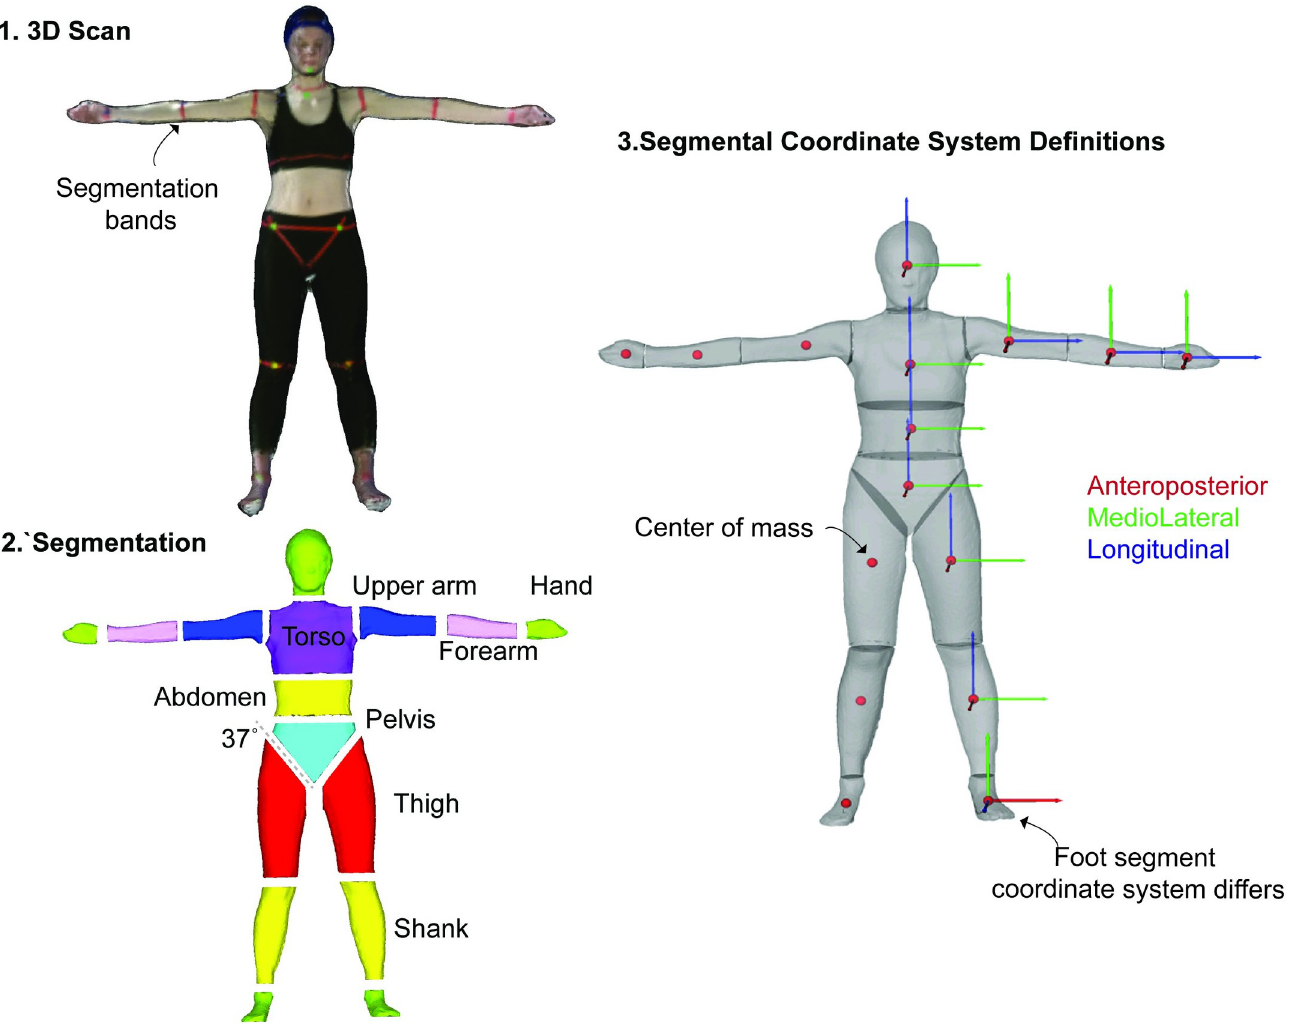
Fig 3. From 3D scan to BSP output estimations. 1. A representative 3D scan in MeshLab. 2. We segmented each 3D scan into 16 individual body segments. 3. Segmental coordinate system definitions for each body segment showing anteroposterior (red), mediolateral (green), longitudinal (blue) axes. Here the red dot is the center of mass. We aligned the foot segment coordinate system such that the longitudinal axe was along the long length of the foot.